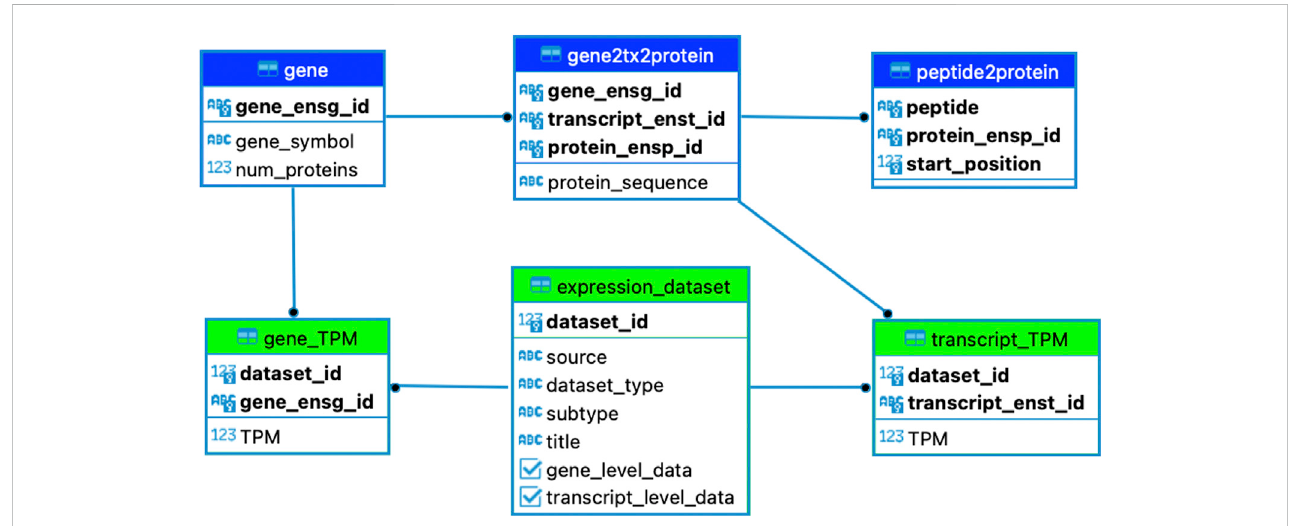
FIGURE 1 pepX Database Schema. The three proteome-related tables of the database (in blue) catalog peptides, proteins, transcripts and genes. The three expression-related tables of the database (in green) track gene- and transcript-level TPM data and associated study